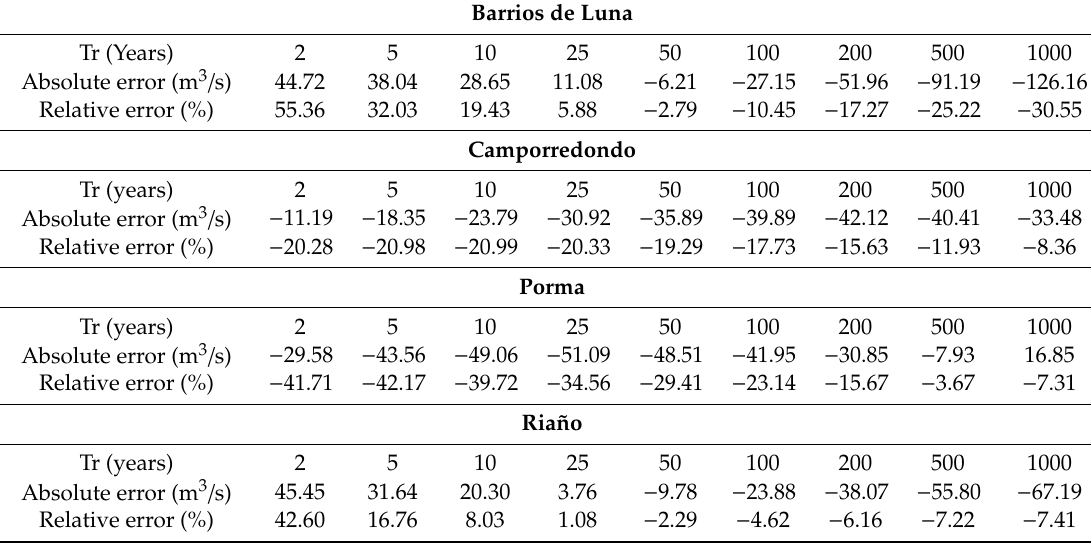
Figure 11. Comparison between flood frequency curves fitted to annual maximum series simulated by the HBV model with observed data and HBV simulations with climate projections in Riaño catchment, using a set of combinations of bias correction techniques. Red lines represent the median of the 12 climate models considered. ( a ) Raw data with no bias correction; ( b ) raw temperature and precipitation with QM linear correction; ( c ) raw temperature and precipitation with QM polynomial correction; ( d ) raw precipitation and temperature bias corrected; ( e ) temperature bias corrected and precipitation with QM linear correction; ( f ) temperature bias corrected and precipitation with QM polynomial correction. Table 3. Absolute and relative errors of HBV simulations of peak flow quantiles in the control period for the best bias correction method identified in each